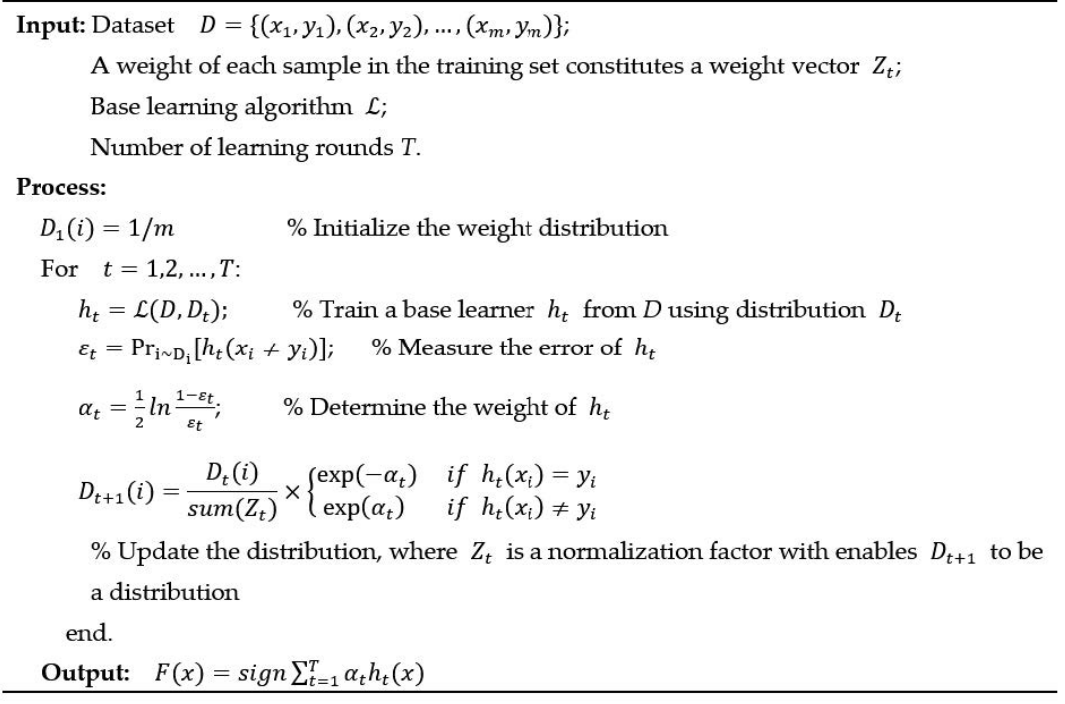
Figure 4. The algorithm of AdaBoost.